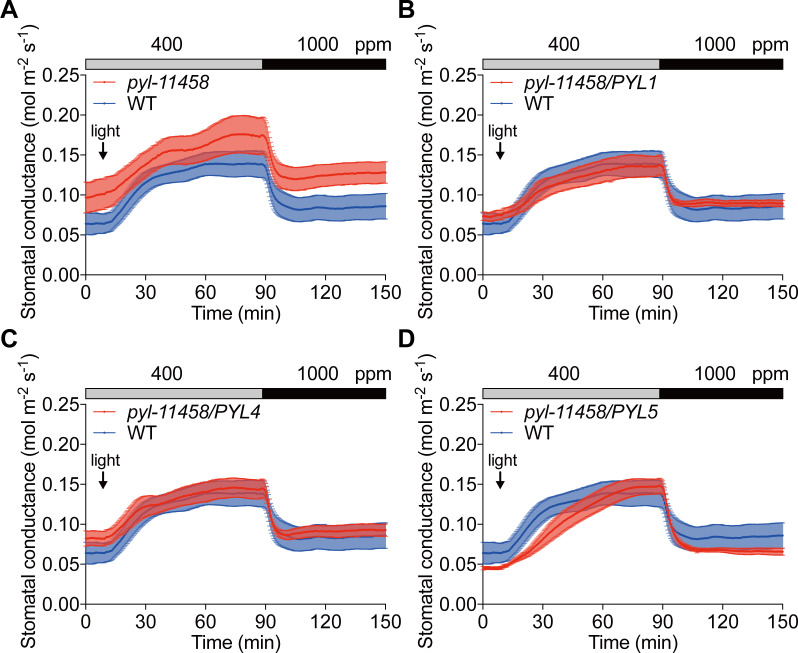
Stomata of ABA receptor quintuple mutant (pyr1/pyl1/pyl4/pyl5/pyl8) and guard cell-targeted (B) PYL1 and (C) PYL4 ABA receptor complemented plants show stomatal CO2 responses similar to wild-type (Col-0) controls.Time-resolved stomatal conductance responses to changes in light and CO2 concentration in Col-0 (WT; A–D). (A) pyr1/pyl1/pyl4/pyl5/pyl8 quintuple mutant (pyl-11458). (B) pyr1/pyl1/pyl4/pyl5/pyl8/pGC1::PYL1 (pyl-11458/PYL1). (C) pyr1/pyl1/pyl4/pyl5/pyl8/pGC1::PYL4 (pyl-11458/PYL4). (D) pyr1/pyl1/pyl4/pyl5/pyl8/pGC1::PYL5 (pyl-11458/PYL5). Gas exchange experiments of intact leaves commenced under dark treatment and then leaves were exposed to 125 µmol m−2s−1 continuous light as indicated by arrow in each panel. CO2 concentrations are shown on top of the data traces in each panel. Note that WT traces in A to D are the same for comparisons, as the indicated genotypes were measured within the same experiments. Note that steady state stomatal conductance levels in pyl-11458 mutants are conditional. Data represent mean of stomatal conductances ± sem. WT (n = 4), pyl-11458 quintuple (n = 4), pyl-11458/PYL1 (n = 4), pyl-11458/PYL4 (n = 5), and pyl-11458/PYL5 (n = 4).Figure 9—figure supplement 2—source data 1.Stomatal conductance values of individual plants used in Figure 9—figure supplement 2.